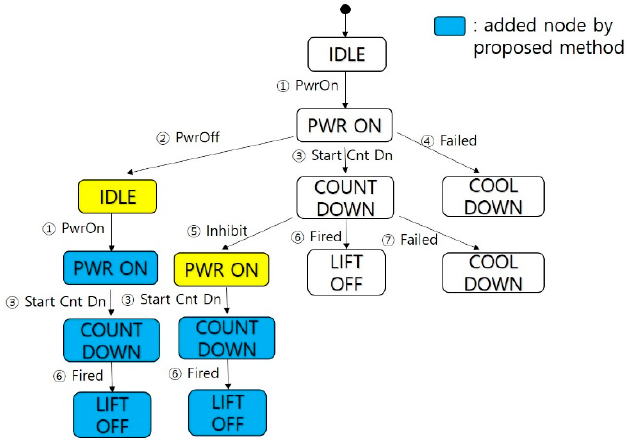
Figure 4. Tree of the sample system using the proposed method.